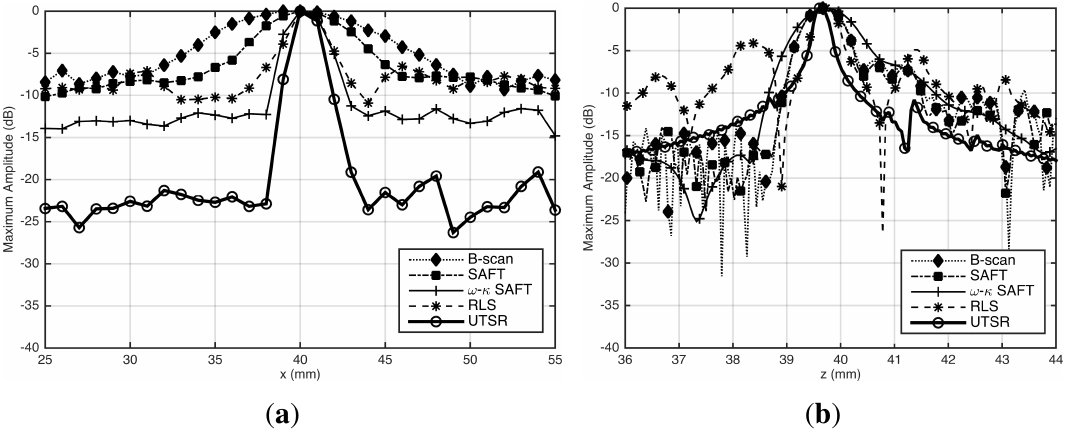
Figure 6. ( a ) Lateral and ( b ) depth profile graphs comparing maximum amplitudes (in dB) of reconstructed images for each image position on the X and Z axes. These profile graph shows SNR of reconstructed images by B-scan , SAFT, ω - k SAFT, RLS and UTSR